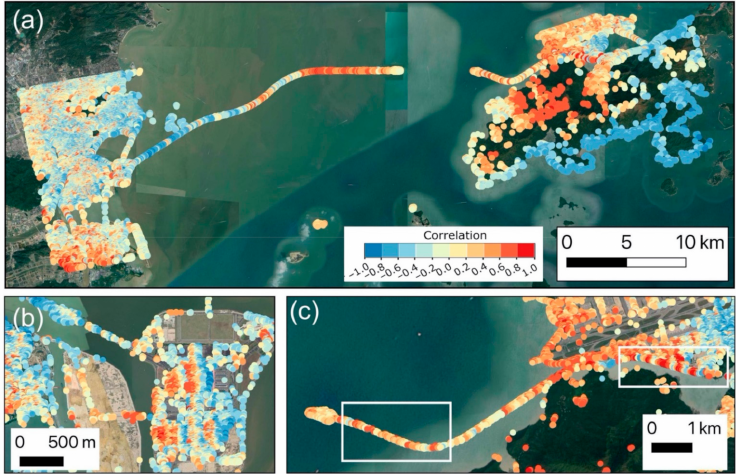
Figure 14. The correlation map between ( a ) temperature and the seasonal component of time-series displacements; ( b ) the cyclic correlation pattern of the buildings in the Zhuhai–Macao Passenger Terminals; ( c ) the white boxes show the cyclic correlation pattern of the bridge and road connecting the east man-made island and the HKIA. The background image is a satellite image from Google